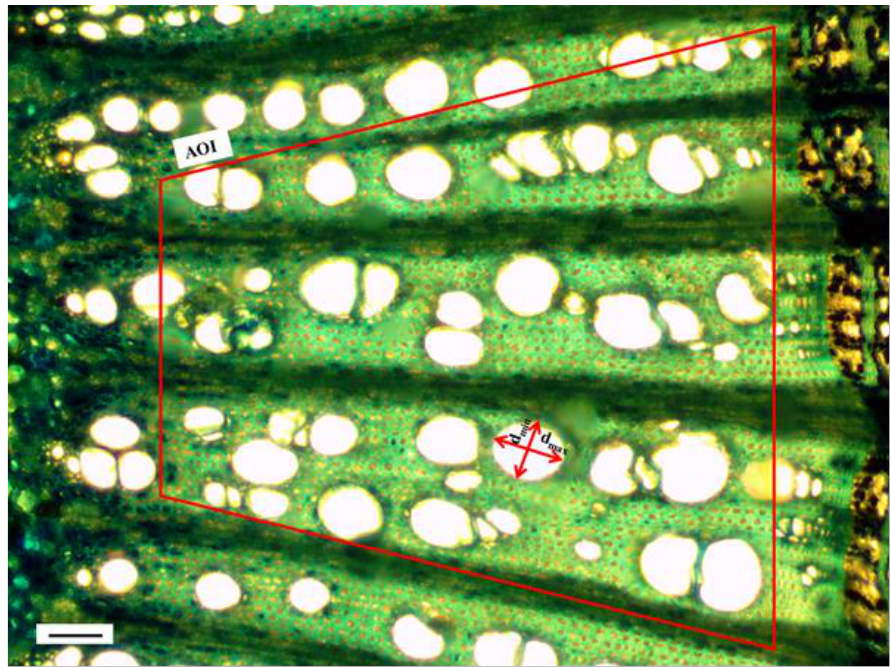
Figure 1. Illustration of representative vessel dimensions measured under the light microscope (4× magnification) on a transverse section from a grapevine cultivar. The maximum diameter (d max ) and minimum diameter (d min ) are easily measured on transverse sections. To calculate the vessel density, the total numbers of vessels per 1 mm 2 were determined. The red polygon shows the area of interest (AOI). All vessels outside the AOI were excluded. Scale bar, 100 μm.